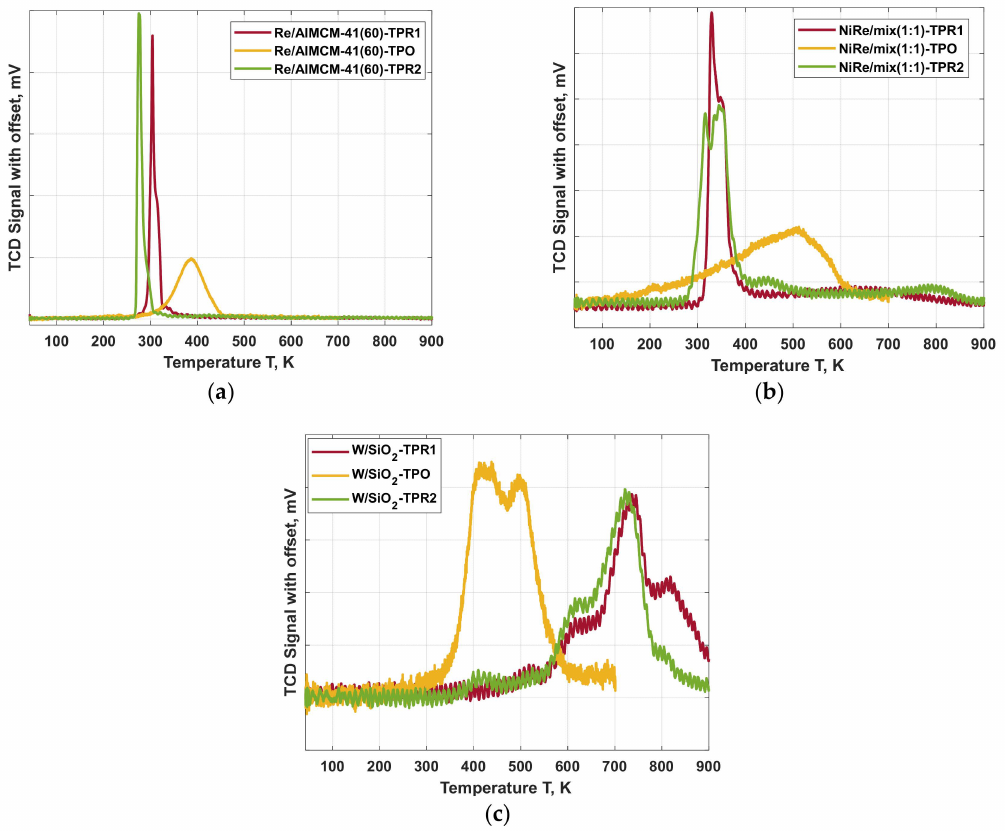
Figure 5. TPR/O/R cycles of the catalysts ( a ) Re/AlMCM-41(60), ( b ) NiRe/mix (1:1) and ( c ) W/SiO 2 applied for the metathesis of ethene and trans-butene towards